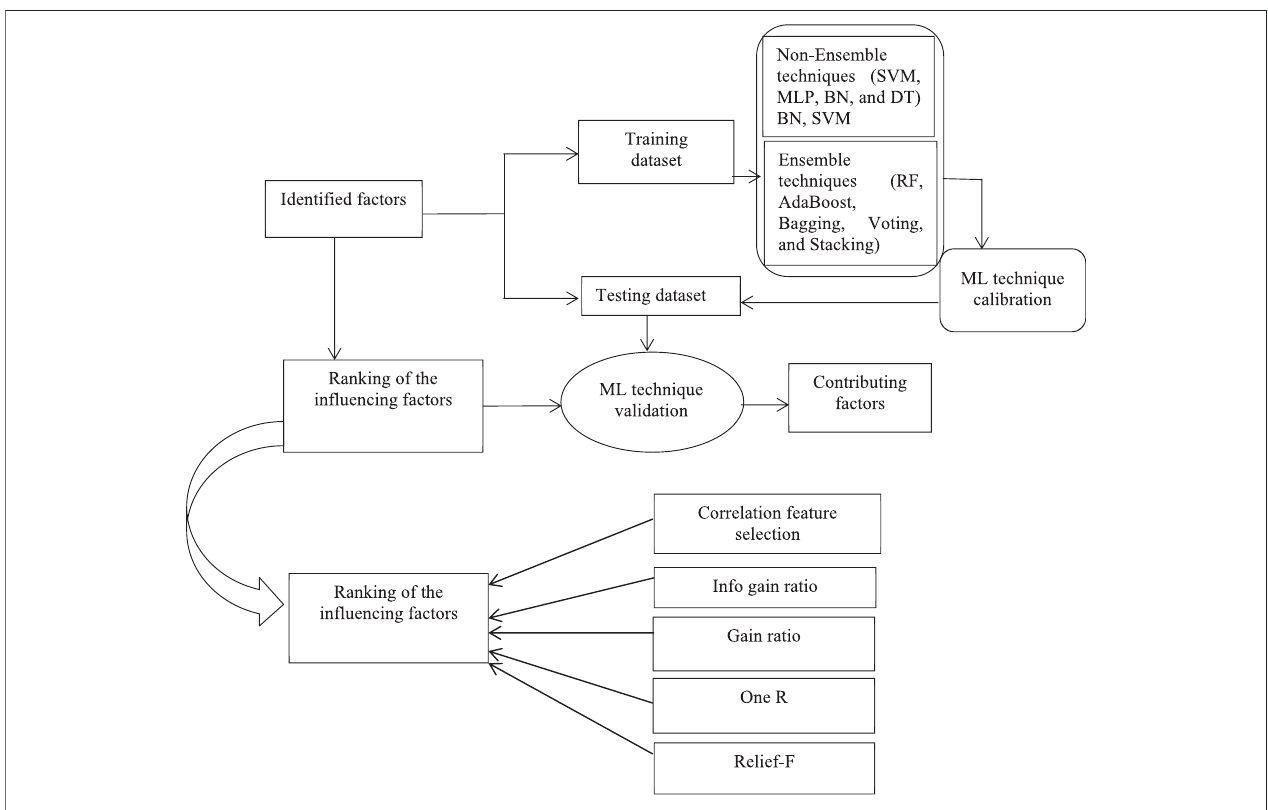
FIGURE 2 | The methodology adopted in this study for ranking geotechnical factors and performing machine-learning for slope-failure predictions.